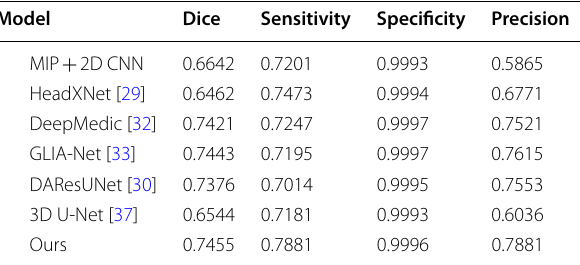
Table 4 Comparison of the proposed model with other attention modules Model